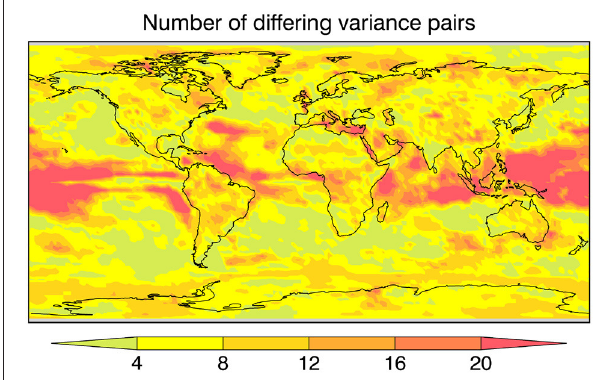
FIGURE 4 | The number of pairs of variances that differ among the 11 analyses at the 95% confidence level according to the Pitman (1939) test which discounts the common